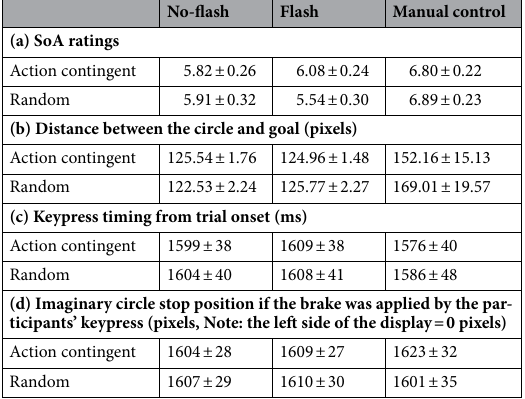
Table 1. Results in experiment 1. Mean ± SE. The values in Manual control are shown as reference information and not